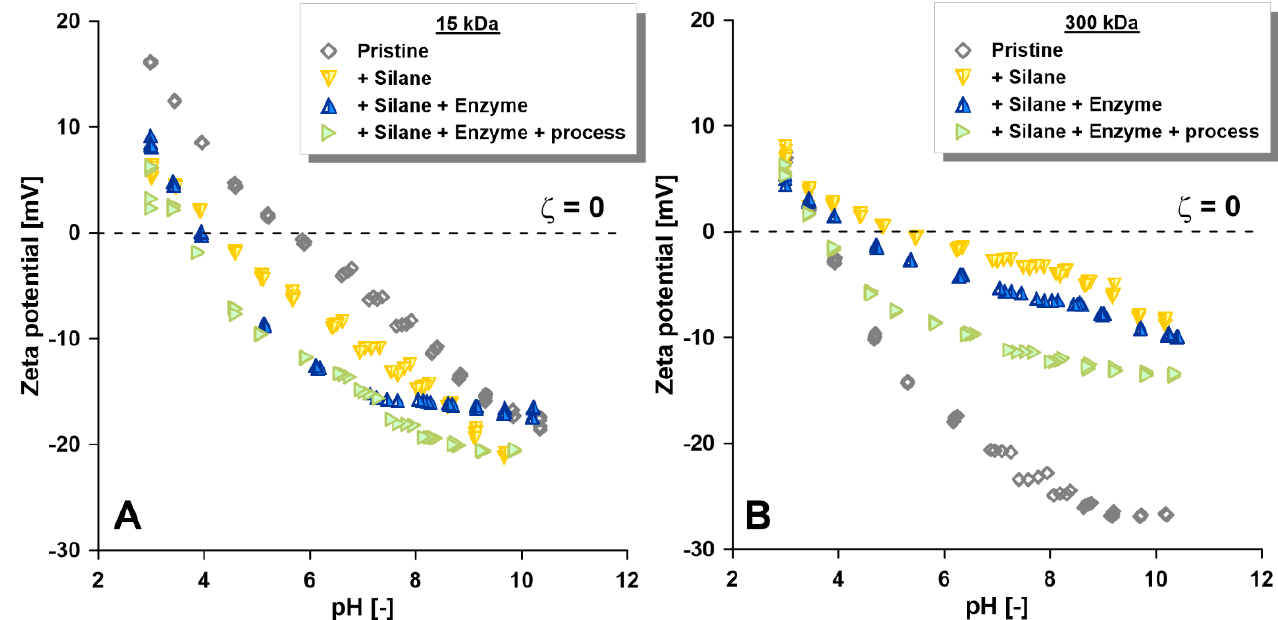
Figure 7. Zeta potential in the pH range of 3 – 10. Impact of all modification steps for the membranes with the smallest, 15 kDa ( A ), and the biggest, 300 kDa ( B ), pore size (MWCO).